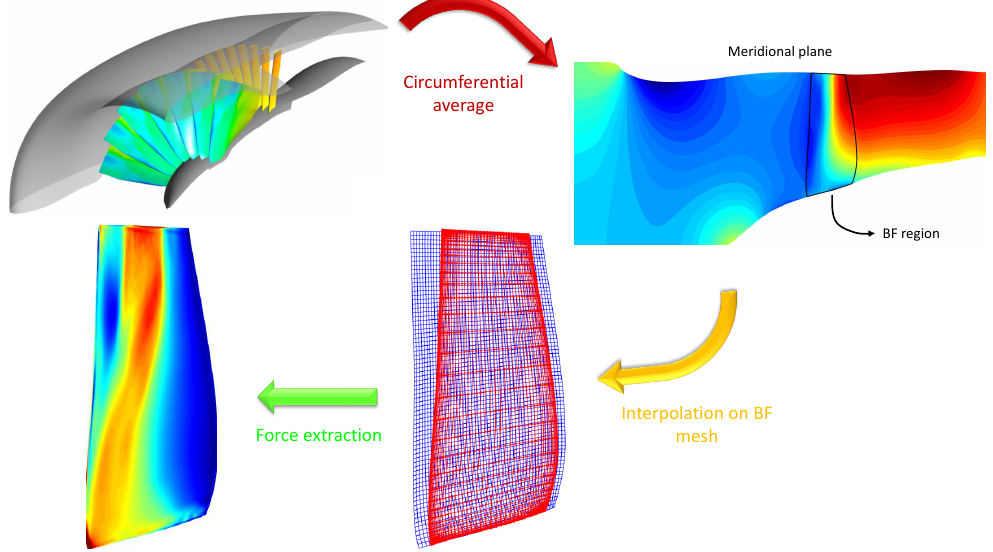
Figure 2. Force extraction work